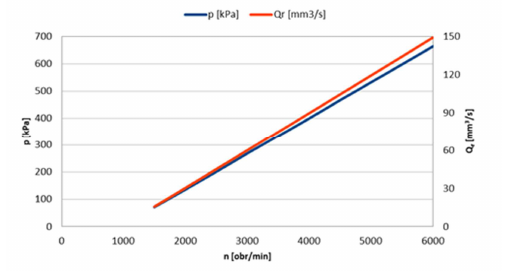
Fig. 8. The courses of pressure and efficiency of the gear oil pump with internal toothing as a function of engine speed The obtained oil pressure distributions for the boundary condition at the inlet in the form of a mass flow of 0.00035 kg/s are shown in Fig. 9. For the boundary condition at the inlet in the form of a constant pressure of 400 kPa, the pressure distributions are shown in Fig. 10 and the flow velocity distributions in Fig. 11. The obtained negative pressure values may indicate the possibility of cavitation, but may also be a result from numerical causes. The figures show that the distributions at the oil outlets for camshaft bearings differ from each other in both speed and pressure. The most difficult conditions prevail in this respect at the outlet